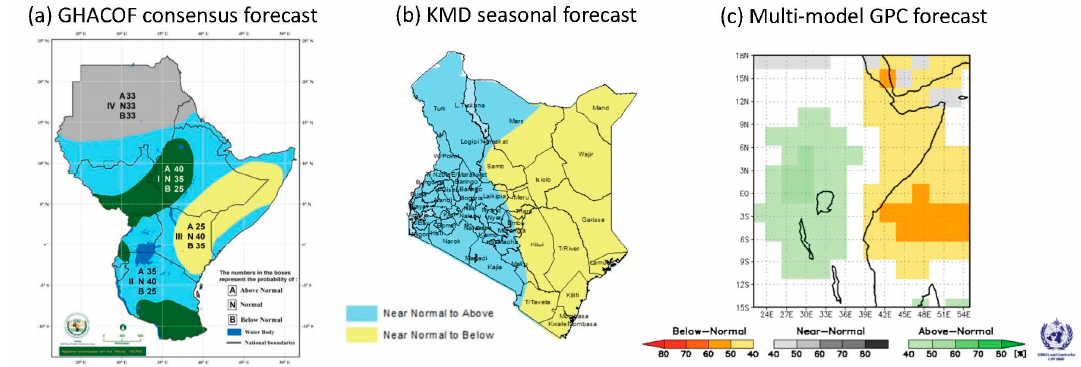
Figure 9. Comparison of seasonal rainfall forecasts for MAM 2018, represented as probability of rainfall terciles. ( a ) Greater Horn of Africa Climate Outlook Forum (GHACOF) consensus issued mid-February 2018. ( b ) Kenya Meteorological Department (KMD) forecast issued early March 2018. ( c )